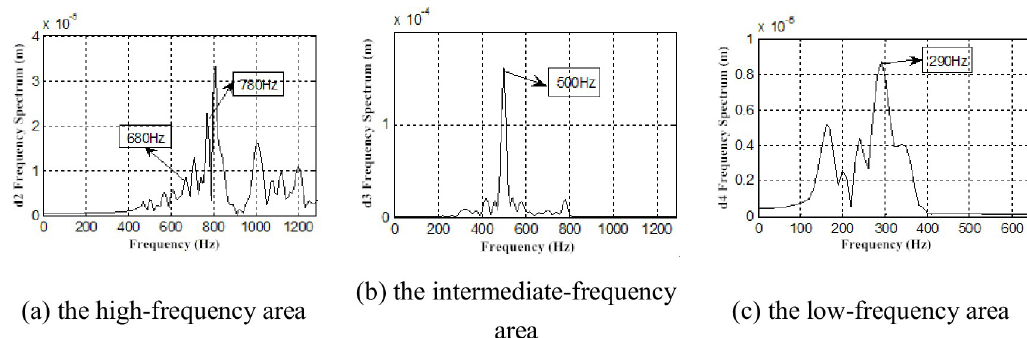
Fig 18. Frequency spectrum of X direction displacement response restructuring signal under F = 1.